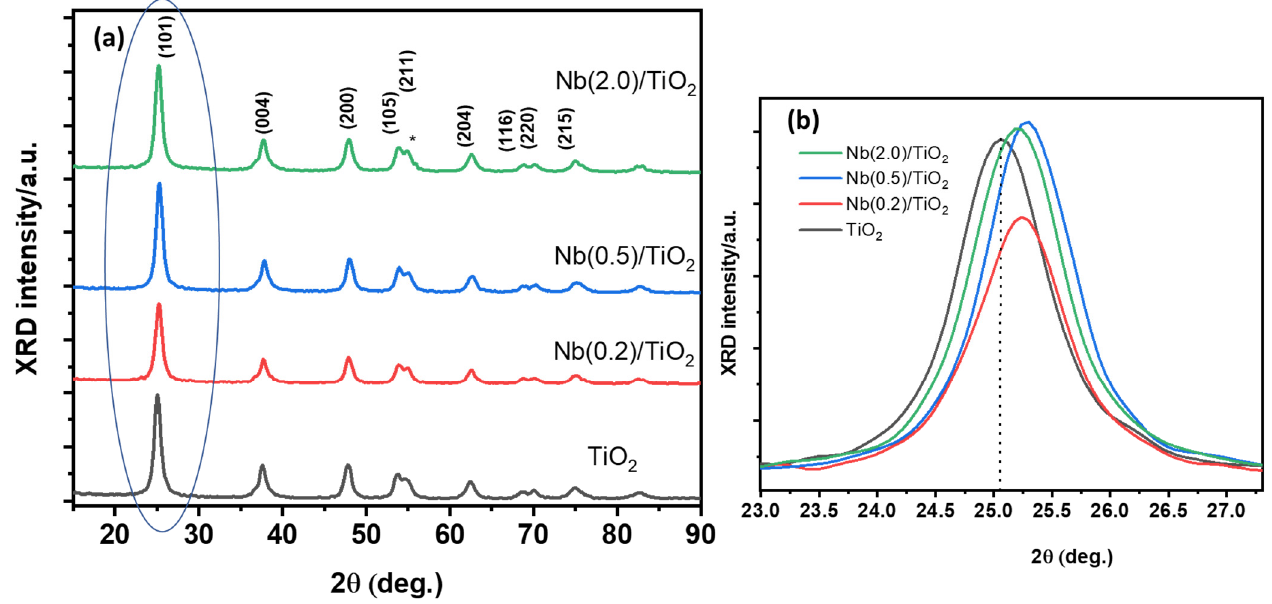
Figure 3. ( a ) XRD patterns of Nb(x)/TiO 2 samples with different molar fractions of niobium (0, 0.2, 0.5, and 2%), and ( b ) shift of the crystal plane (101) due to the effect of Nb. The peak marked by an asterisk * belongs to niobium